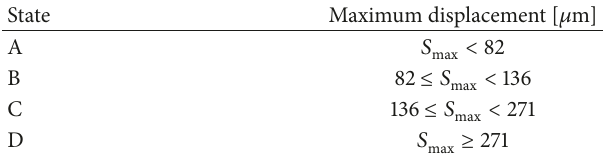
Table 5: 𝑆 max limits for 200 RPM.